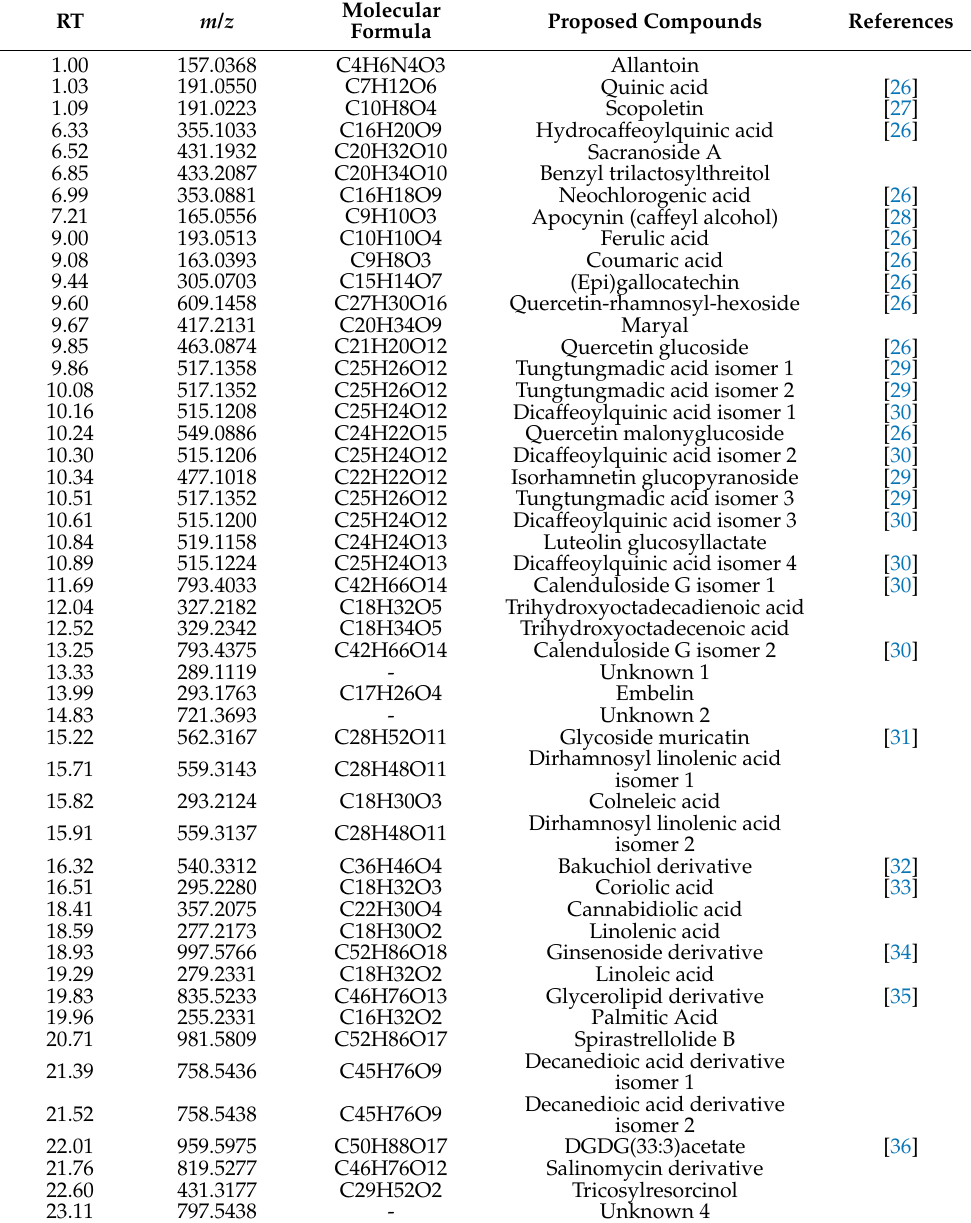
Table 2. Annotated compounds in S-EE by HPLC-ESI-QTOF-MS.